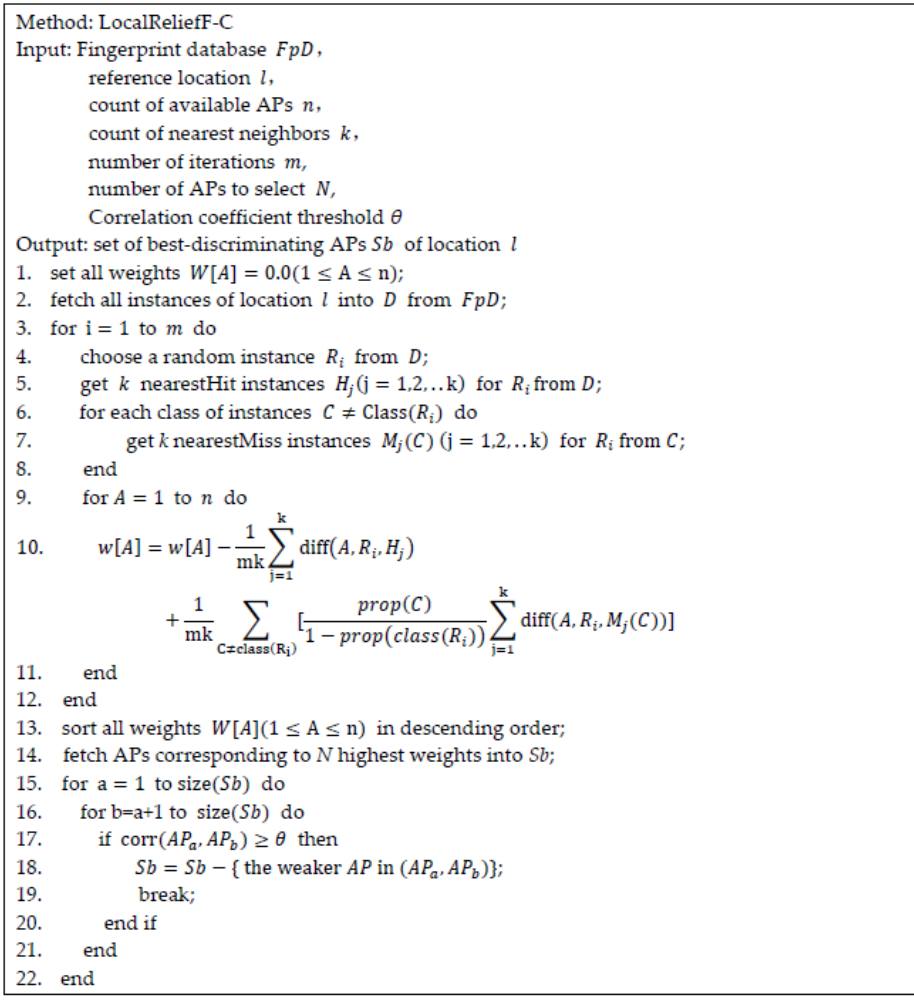
Figure 1. Pseudo-code of LocalReliefF-C.